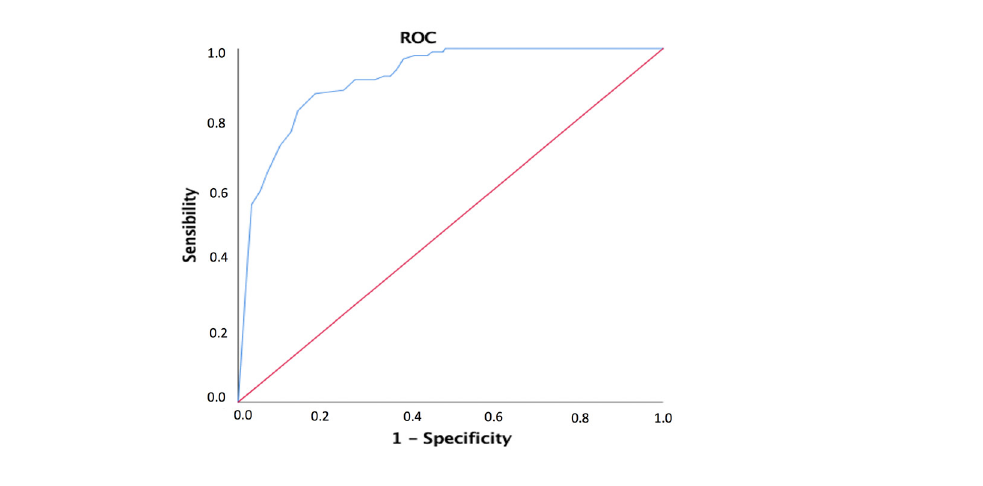
Table 5. Quartiles scoring for each factor in the sample.